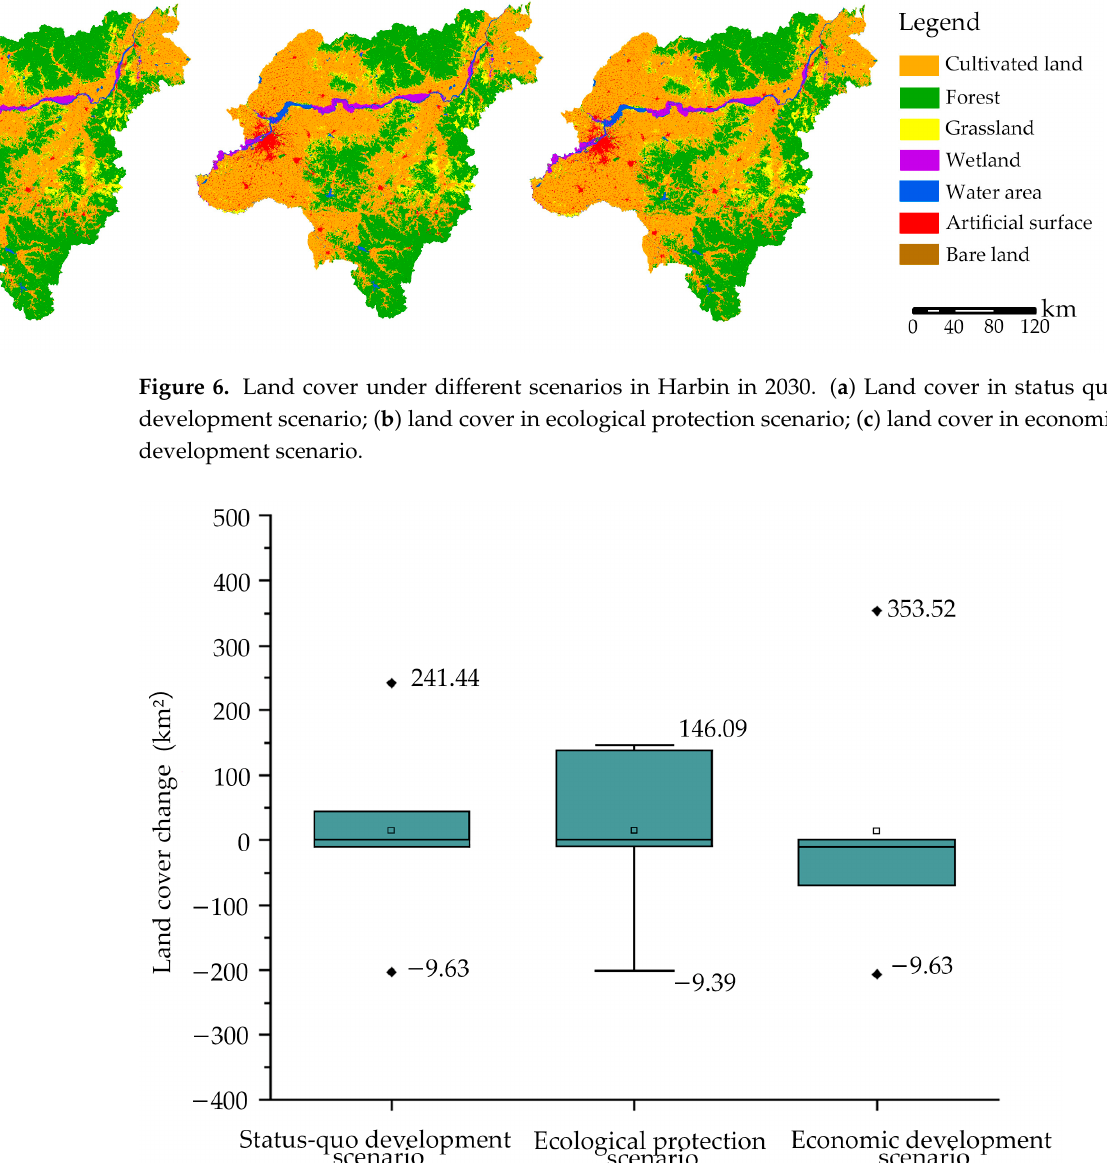
Figure 7. Land cover change under different scenarios in Harbin in 2030.